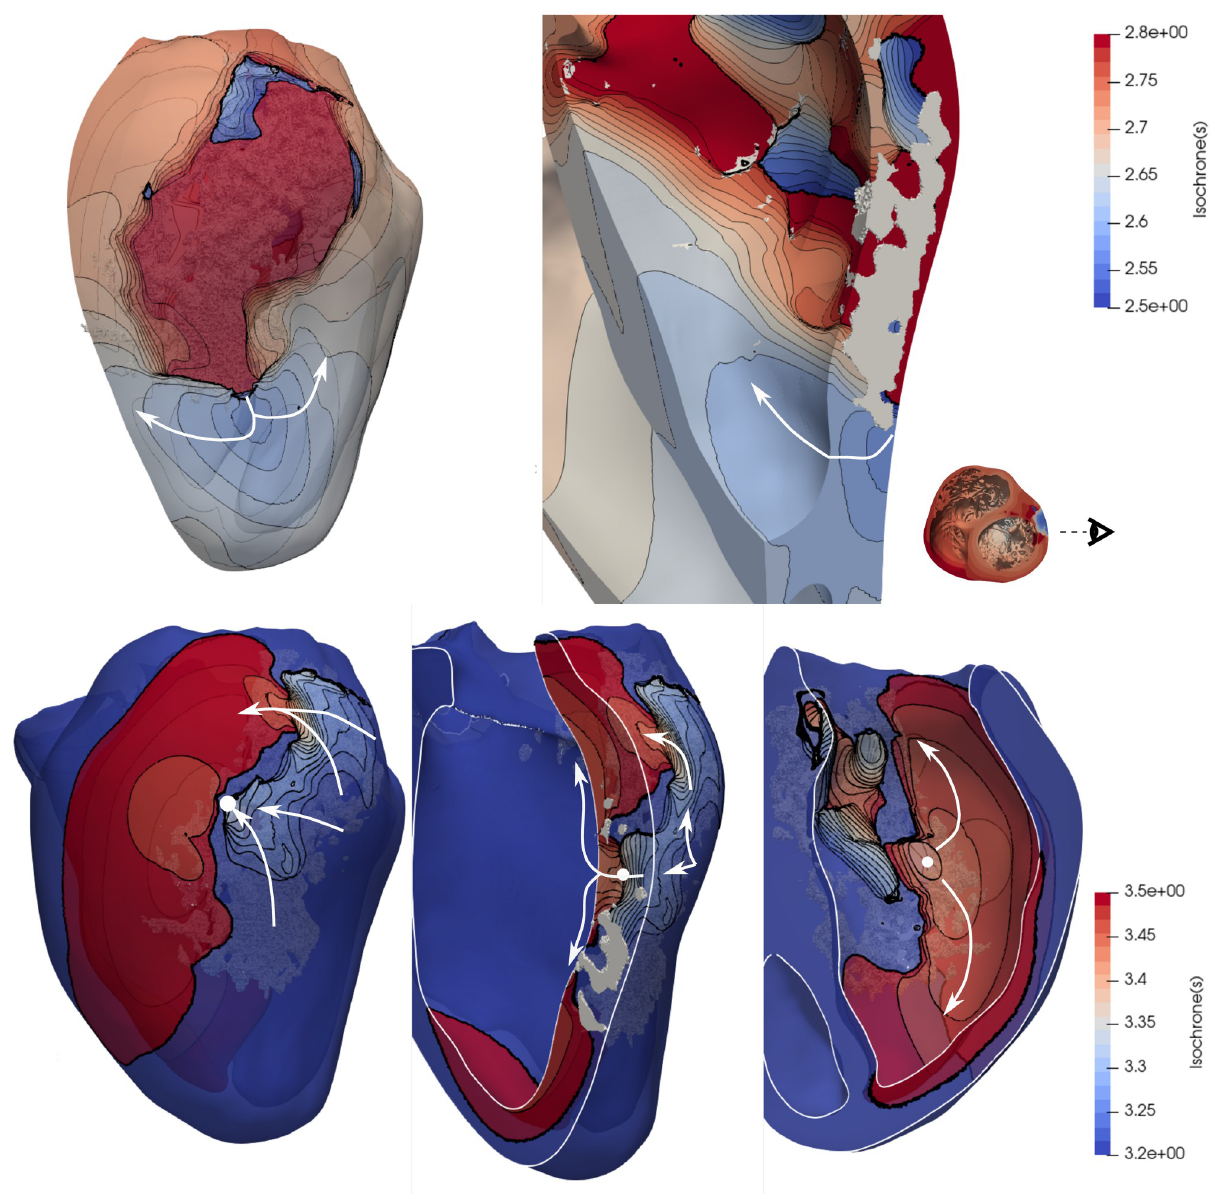
Fig 11. Isochrone map of the ventricular tachycardia obtained from the female smooth simulations with RVApex stimulus location (same as in Fig 9B) at two different time intervals shown in the color bars. Dense scar is observed in white color. A white circle shows a transmural channel, which provides a different reentry pathway to the shown in Fig 10. S2 Video in S1 File shows this VT.